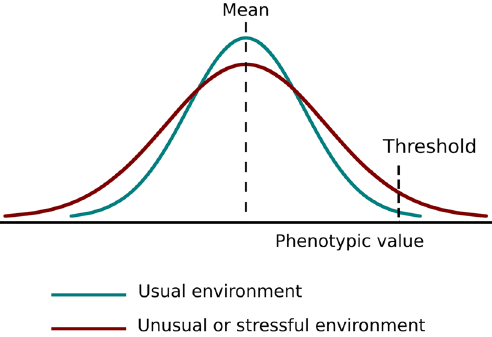
Figure 1. Representation of phenotypic (de)canalization. Expected distribution for the trait values in a hypothetical population under usual and unusual or stressful environments, determining canalized